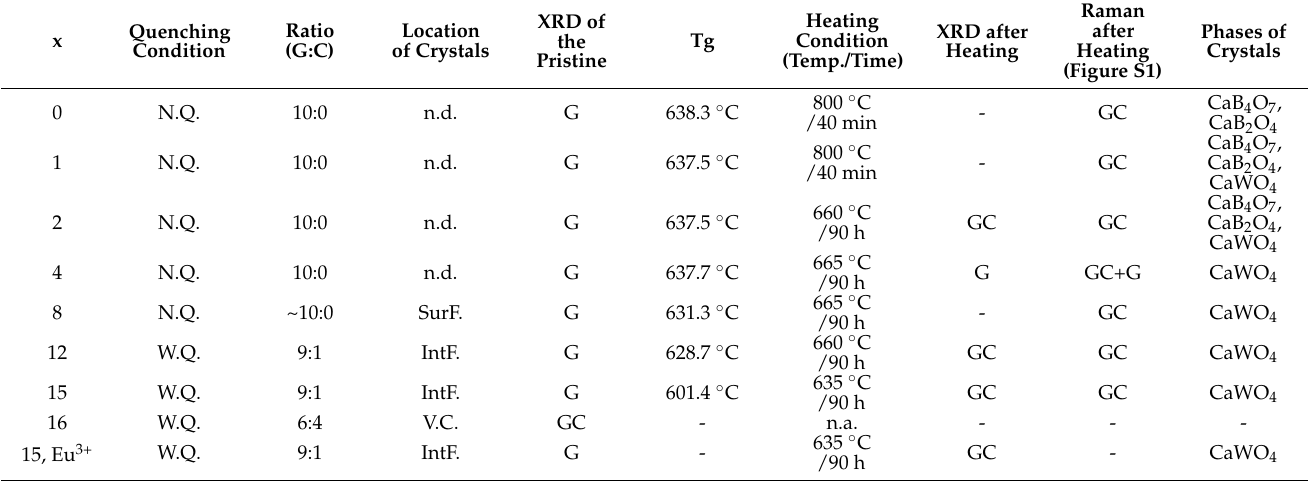
Table 1. Summary of sample preparation: Quenching condition (N.Q.: Normal Quenching, W.Q.: Water Quenching), Ratio of Glass (G) and Crystal (C) inside the species quenched, Location of crystals (SurF.: Surface, IntF.:Interface between glass and crucible, V.C.: Volume Crystallization, n.d.: not detected), Results of XRD and Glass Transition temperature Tg for the obtained glasses (pristine), Heating condition (Temperature and Time) for fabricating glass-ceramics (GC), Results of XRD and Raman experiments, and Detected phases of crystals after the heat-treatment, for (100 − x )(33CaO-67B 2 O 3 ) − x Ca 3 WO 6 (or Ca 2.98 Eu 0.02 WO 6 ) samples. (-: no data; n.a.: not